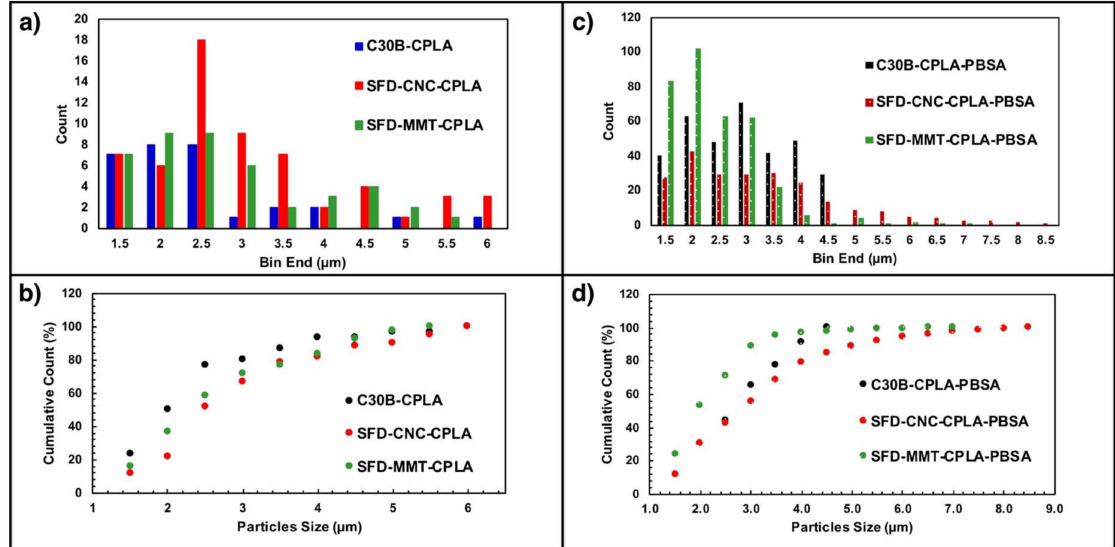
Figure 11. Particle size distribution of C30B, SFD-CNC and SFD-MMT in CPLA ( a , b ) and CPLA-PBSA ( c , d ) samples.